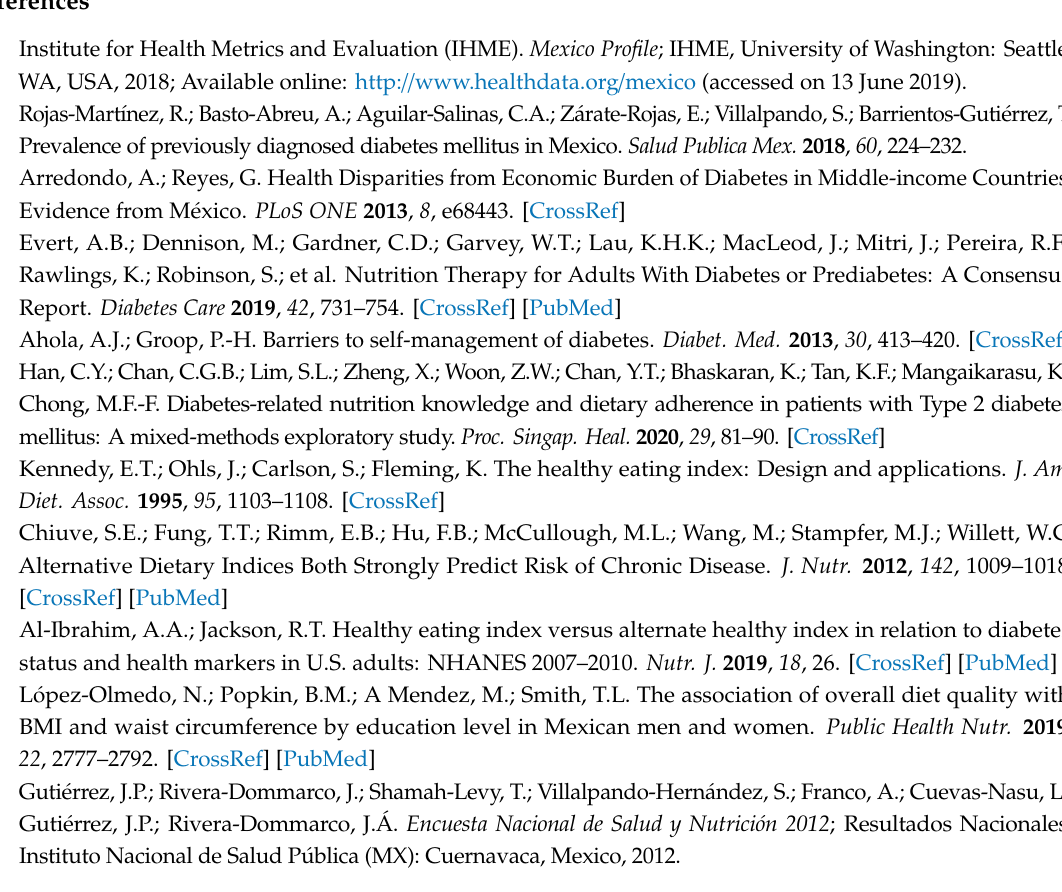
Table S1. Sex-stratified unadjusted Mexican Alternate Healthy Eating Index Score and components in Mexican diabetes status. Table S3. Sex-stratified unadjusted intakes of macronutrients in Mexican adults by diabetes status. Author Contributions: N.L.-O. and T.B.-G. were responsible for study design, results interpretation, and